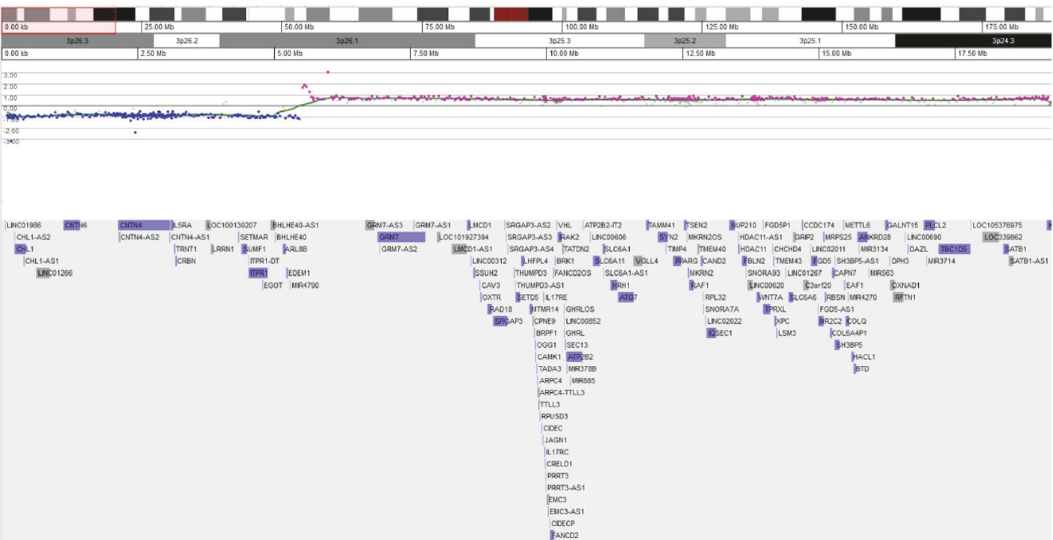
Figure 1: Copy number changes in chromosome 3p. Copy loss in bands 3p26.3-p26.1 (genomic coordinates: chr3:101072 5470617), estimated size 5.37-5.53 Mb. Copy gain in bands 3p26.1-p24.3 (genomic coordinates: chr3:5530662 19214536), estimated size 13.68-13.75 Mb. GRCh37/hg19 (Feb. 2009).